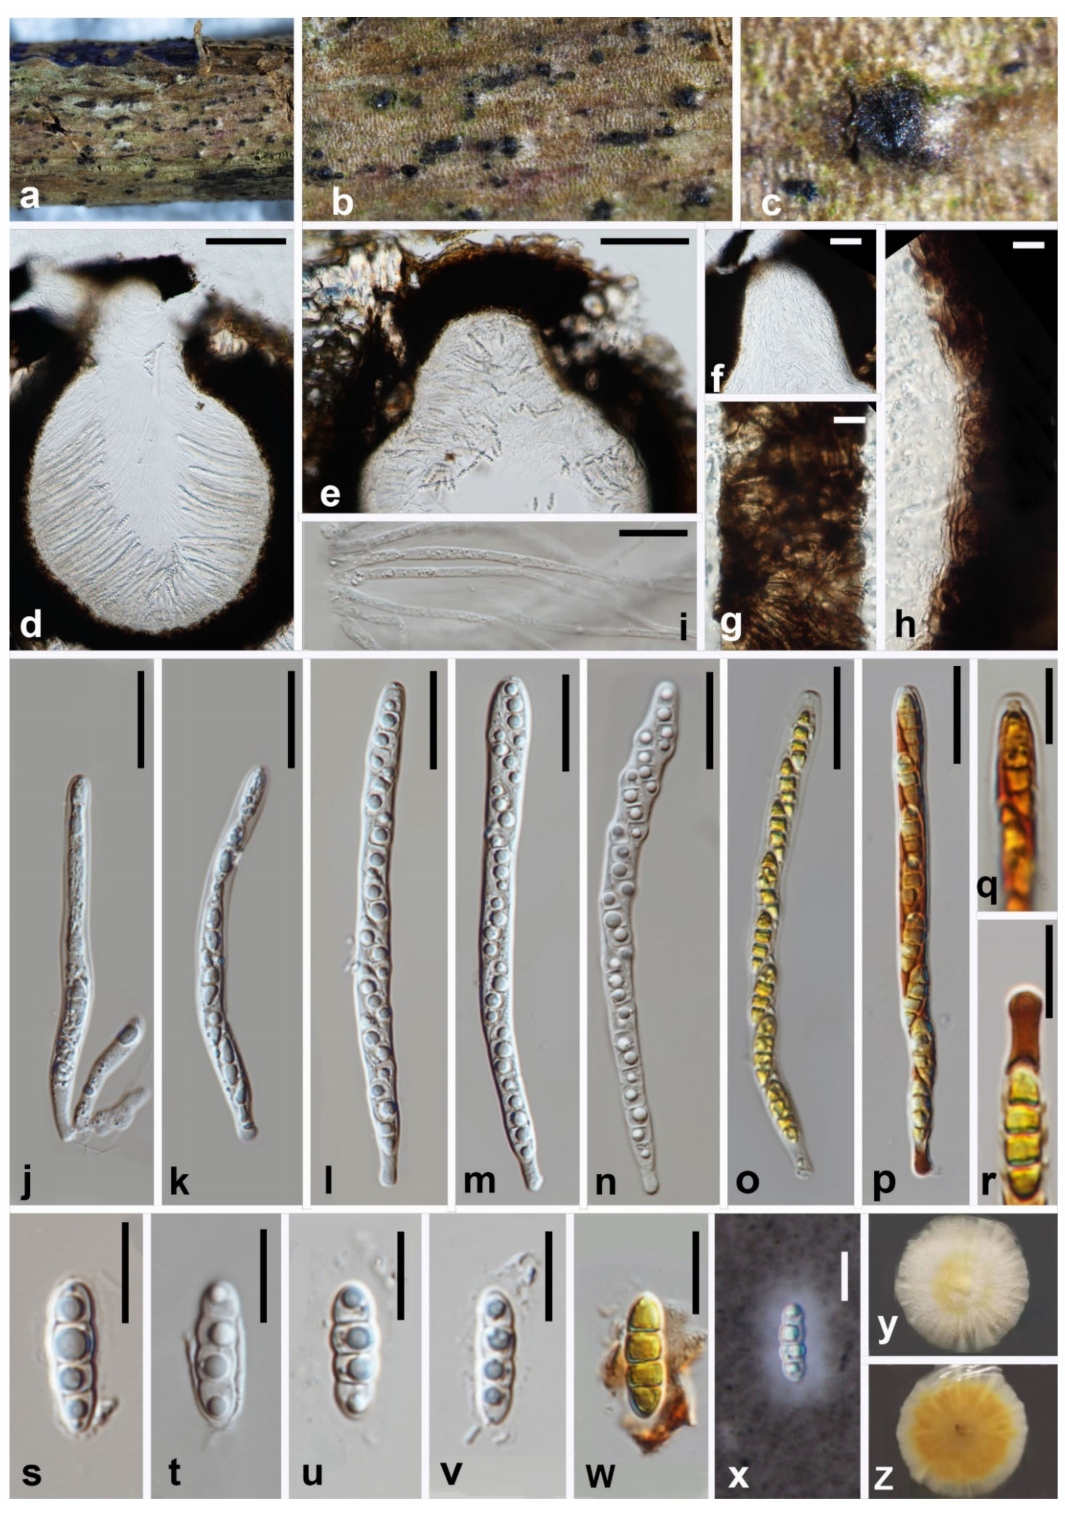
Figure 4. Melomastia sichuanensis (HKAS 121313, holotype). ( a – c ) Ascomata on the substrate. ( d , e ) Vertical section of ascoma. ( f ) Vertical section of ostiole. ( g,h ) Peridium. ( i ) Pseudoparaphyses. ( j – p ) Asci (( o , p ) in Lugol’s iodine). ( q ) ocular chamber in Lugol’s iodine. ( r ) pedicel in Lugol’s iodine. ( s – x ) Ascospora (( w ) in Lugol’s iodine, x in India ink). ( y , z ) Upper and reverse view of the colony on PDA after 14d. Scale bars: ( d , e ) = 100 µ m, ( f ) = 40 µ m, ( g , h , q – x ) = 10 µ m, ( i – p ) = 20 µ